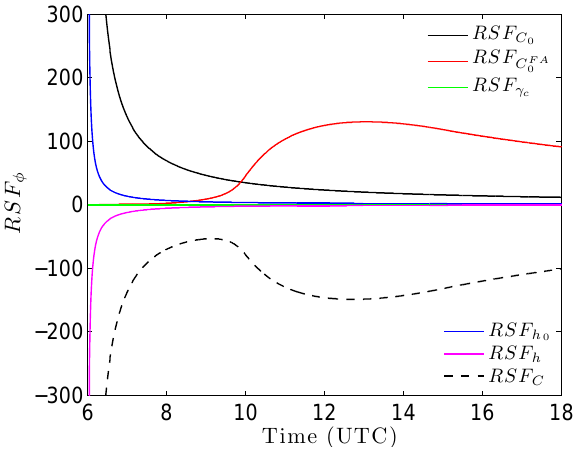
Fig.7. TimeevolutionofthenormalizedsensitivitiesoftheinferredCO 2 surfacefluxtoallthevariables( RSF φ ,seeexpression25)forthe controlcase. Fig. 7. Time evolution of the normalized sensitivities of the inferred CO 2 surface flux to all the variables (RSF φ , see expression 28) for the control